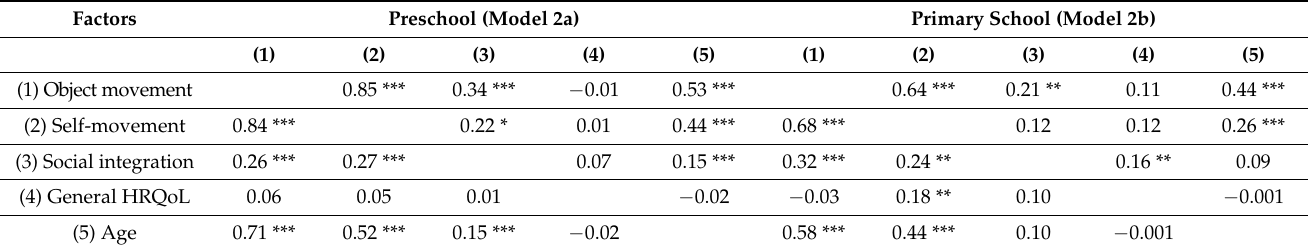
Table 5. Intercorrelations between the variables in model 2 (subsample